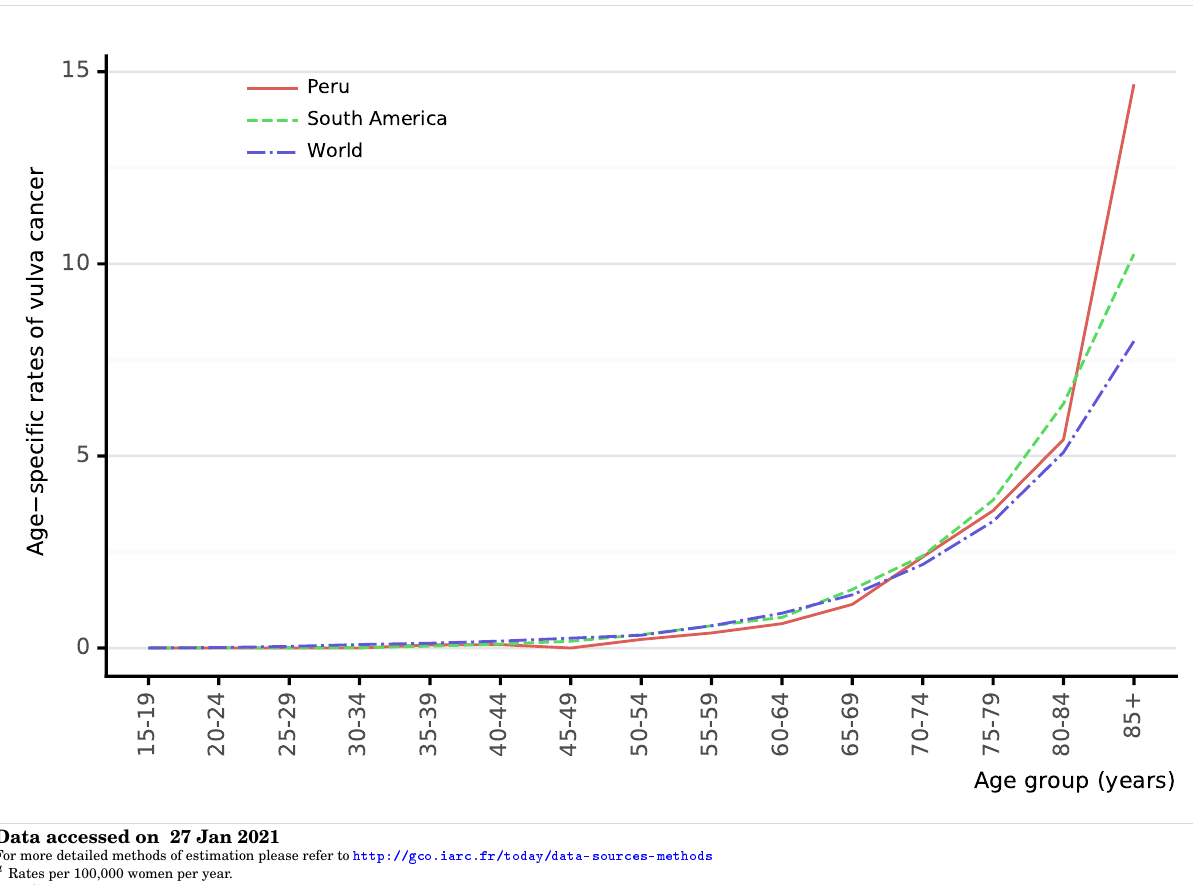
Figure 115: Comparison of age-specific vulva cancer mortality rates in Peru, within the region, and the rest of